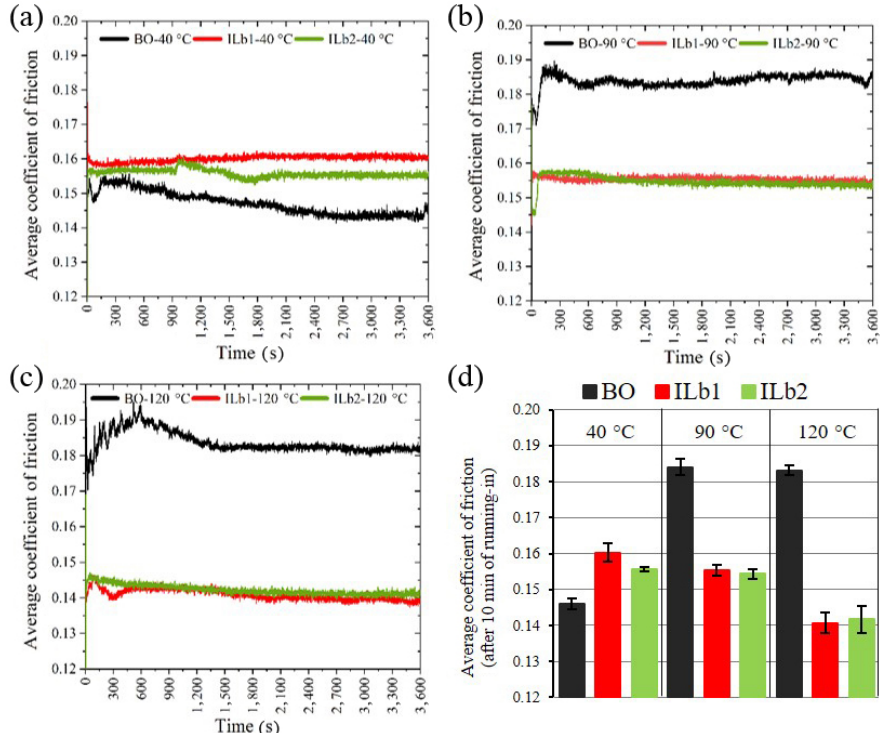
Fig. 5 Evolution of COF from each liquid at (a) 40 °C, (b) 90 °C, and (c) 120 °C. (d) Average values of the COFs calculated from three different